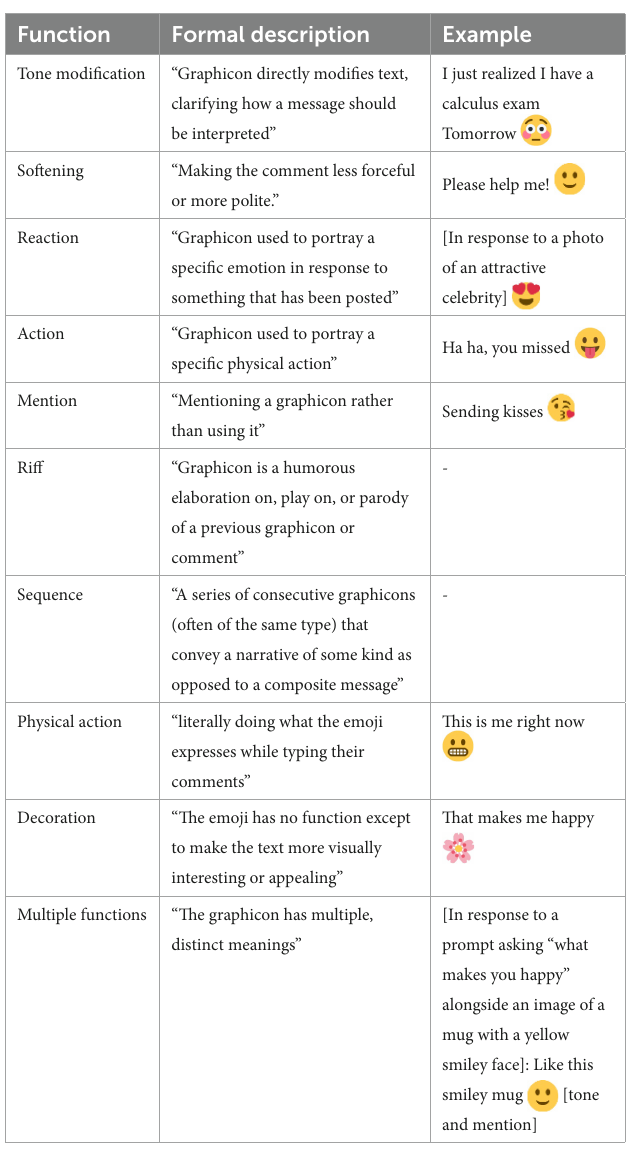
TABLE 1 Formal and lay descriptions of the pragmatic